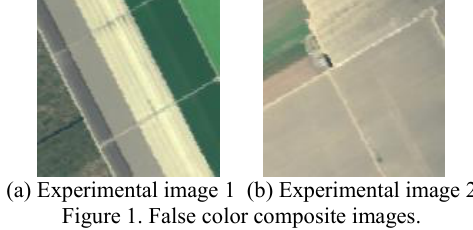
Figure 1. False color composite